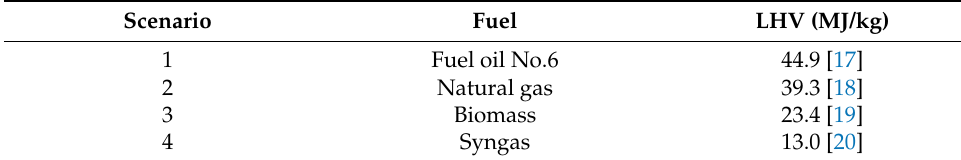
Table 1. Four scenarios for the proposed CCHP system.